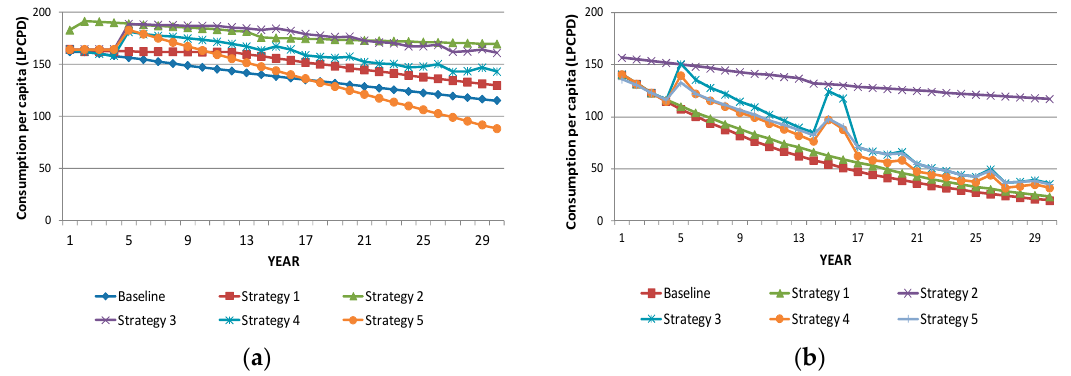
Figure 9. Consumption per capita over the planning horizon for the ( a ) slow growth and ( b ) very fast growth scenarios.